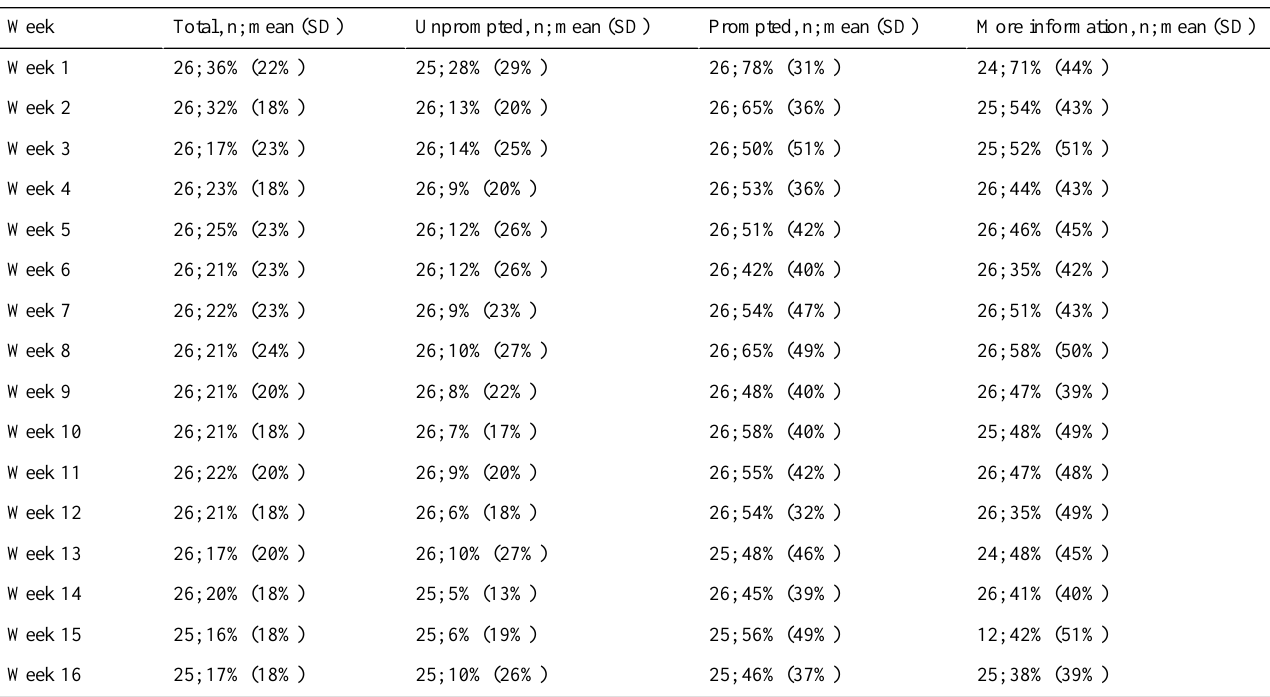
Table 3. Means and SDs for text message responsivity (%) across categories of text messages received weekly during the intervention.